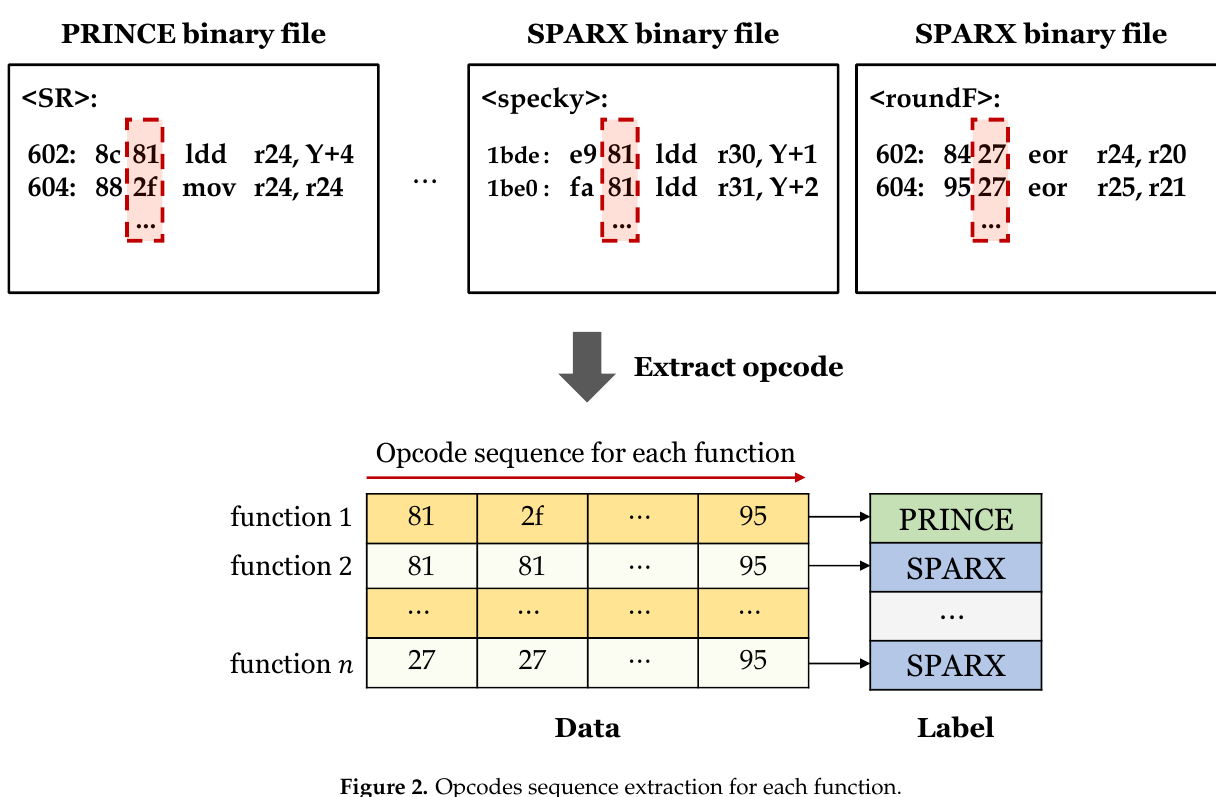
Figure 2. Opcodes sequence extraction for each function.